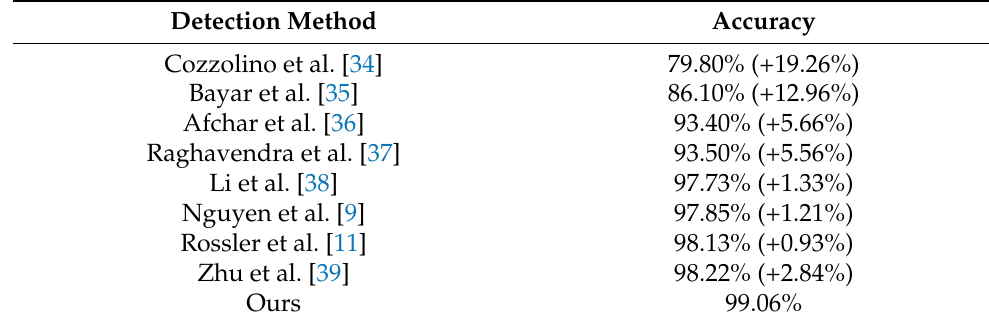
Table 3. Comparison of accuracy between the proposed method and state-of-the-art methods on the Face2Face manipulation type.